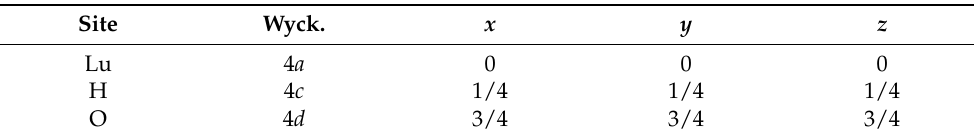
Table A1. The crystal structure parameters of cubic LuHO based on X-ray diffraction data at ambient temperature A1 .